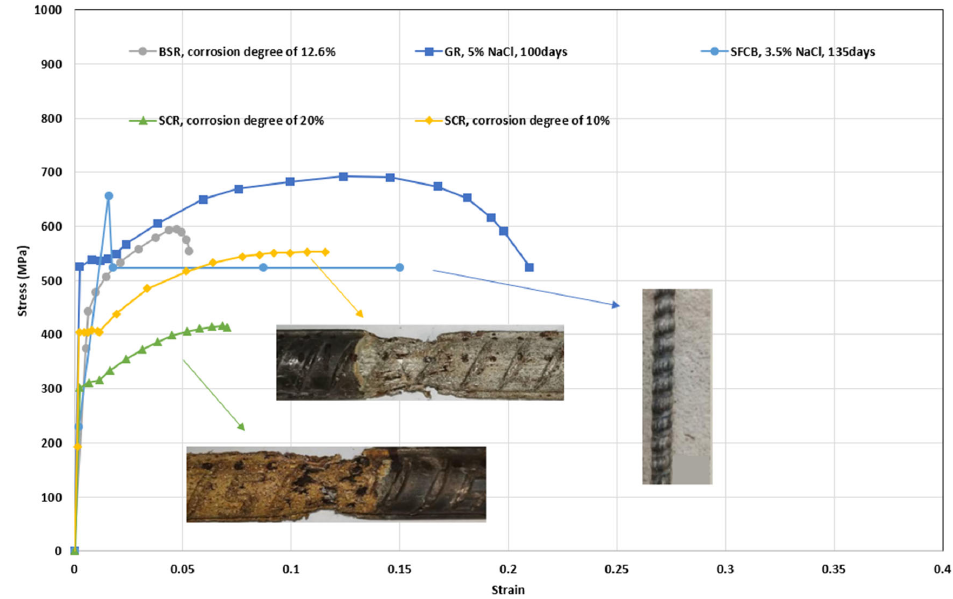
Figure 8. Tensile behaviors of BSR [106], GR [70], SFCB [39], and SCR [33] after corrosion. Table 5. Accelerating tests of uncoated bars and coated reinforcements.